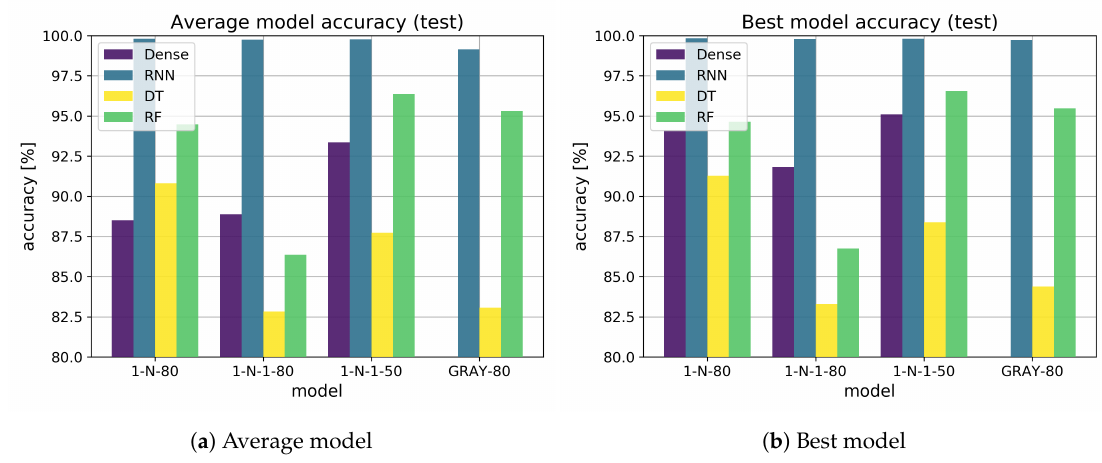
Figure 5. Accuracy